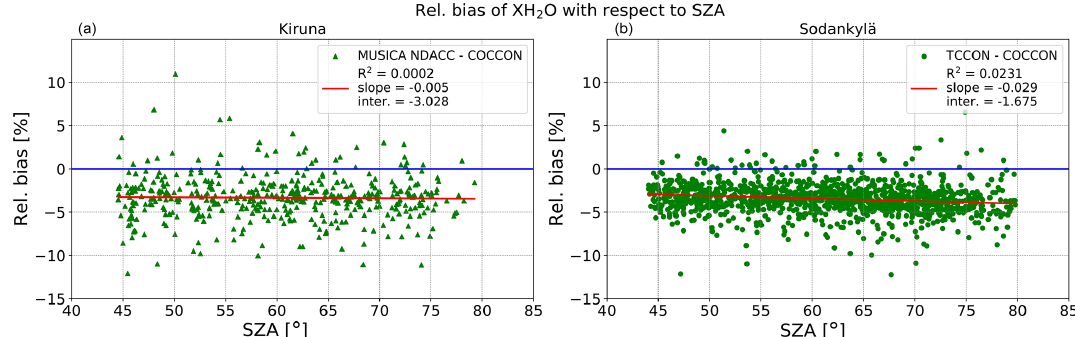
Figure 4. Dependence of the XH 2 O difference (MUSICA NDACC − COCCON) at the Kiruna site (a) and the difference (TC- CON − COCCON) at the Sodankylä site (b) on the SZA. The solid red line represents the fitting line.